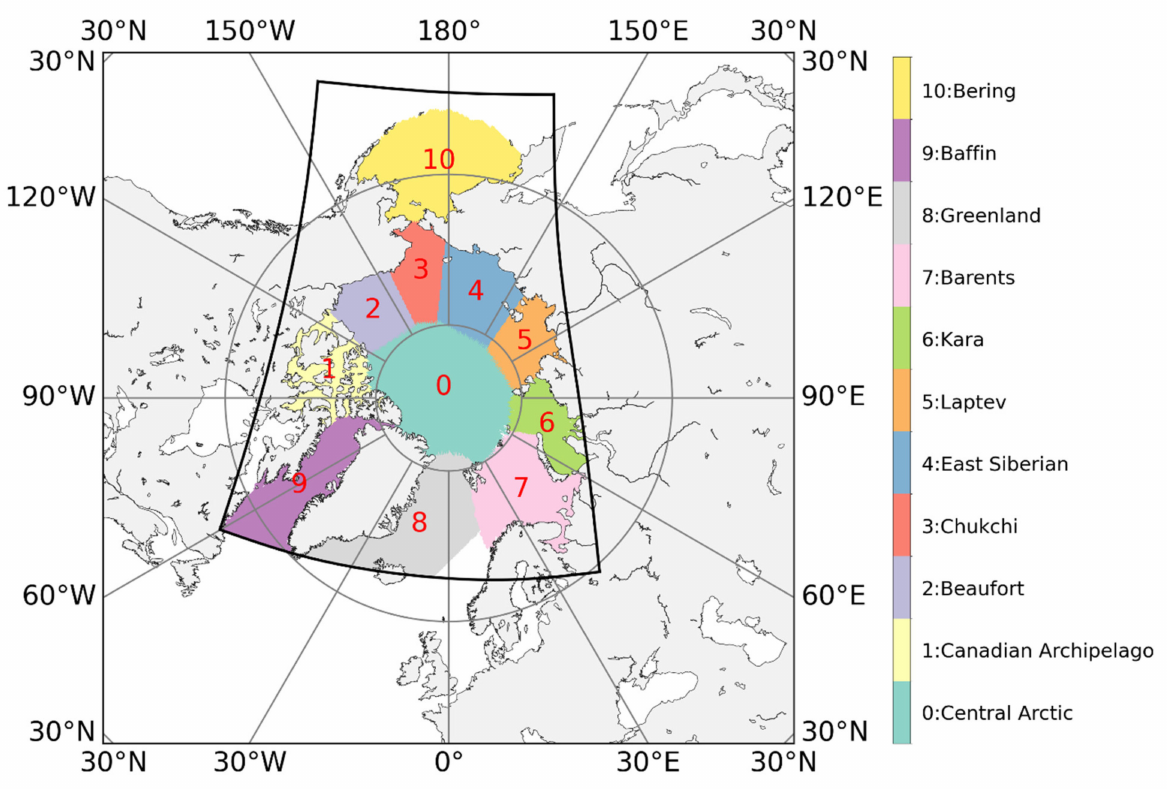
Figure 1. Subregions of the Arctic Ocean within the model domain with the same definition in Parkinson et al. [39], Meier et al. [40] and Liu et al. [41], which are shaded with different colors. Black line denotes the boundaries of the model